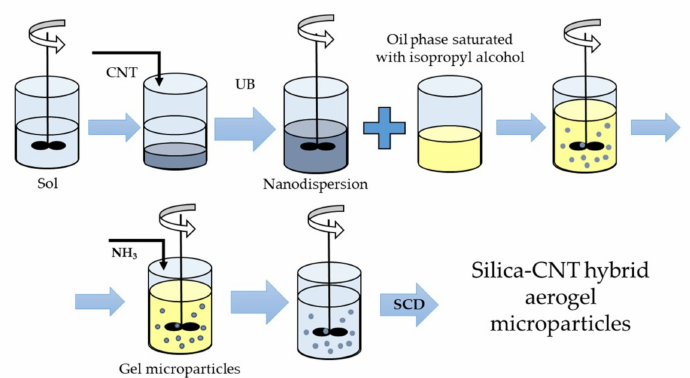
Figure 1. Synthesis of silica–carbon nanotube (CNT) hybrid aerogel microparticles. UB is ultrasonic bath; SCD is supercritical